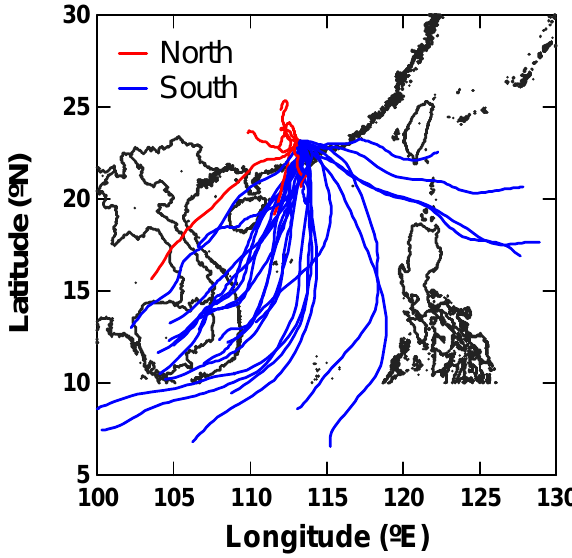
Fig. 4. Three-day back trajectories each started at 00:00h from the observation site (23.13 ◦ N, 113.26 ◦ E, and 50ma.g.l.). The trajec- tories were calculated using HYSPLIT-4 model (NOAA/ARL, FNL meteorological archived